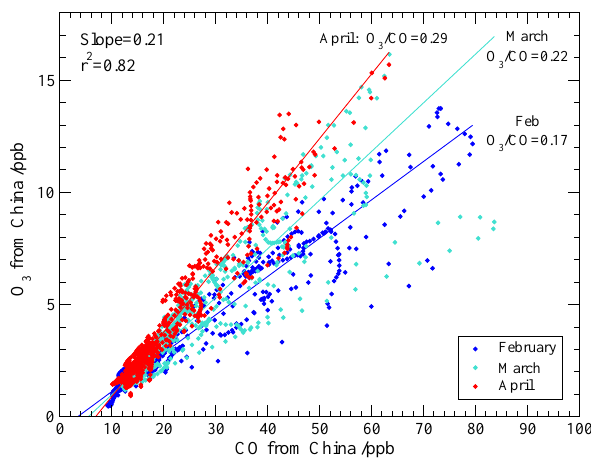
Fig. 8. Relationship between Chinese contributions to surface O 3 and CO over Tokyo revealing the increase in photochemical activity between February and April in 2001.